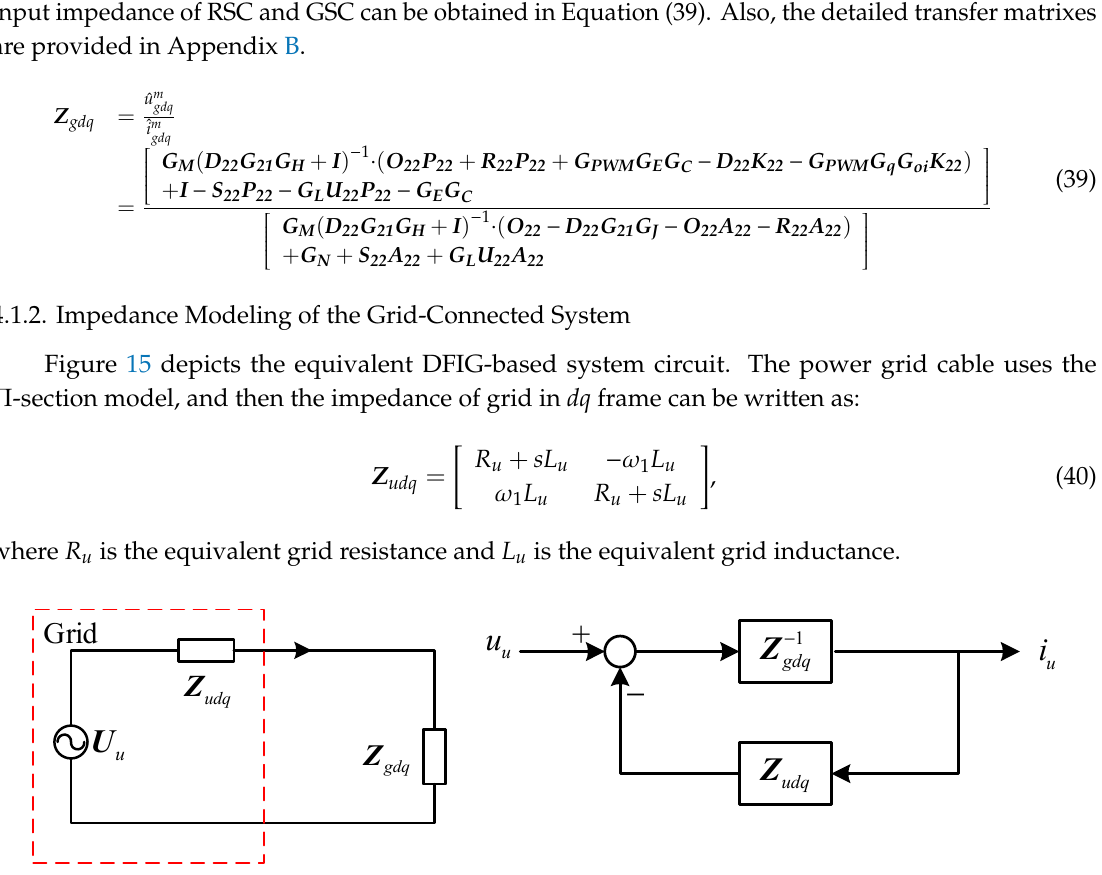
Table 1. The electrical parameters of the DFIG-based system.